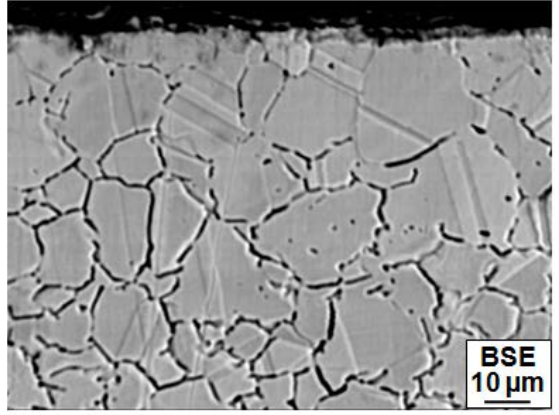
Figure 3: BSE microstructure of the individual wire near failed end showing dislodged grain structure at the surface and dark network along grain